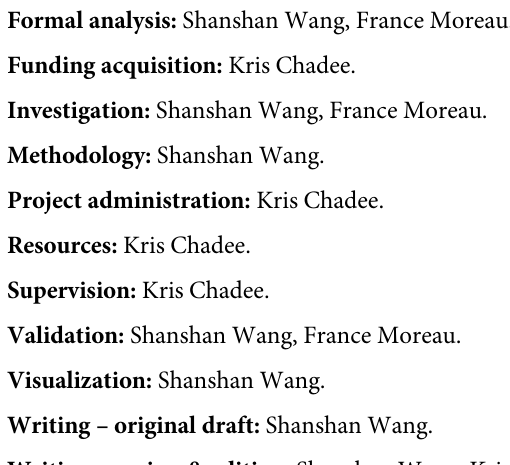
S6 Fig. Protein-protein interaction enrichment analysis on downregulated and upregu- lated pathways following E . histolytica contact with macrophage. Based on the proteomics analysis in Eh -induced hyperactivated macrophages, a protein-protein interaction assay was conducted by STRING protein-protein interaction analysis. ( A ) Shown is the network of enriched terms within the downregulated pathway (Apoptotic signaling pathway and mem- brane trafficking), where connections that share the same cluster typically interact to each other. ( B ) Network demonstrating the interactions between downregulated pathway and upre- gulated pathway (Regulation of proteolysis and secretion by cell) in hyperactivated macro- phages by STRING analysis. ( C ) Volcano plot of proteins from both downregulated and upregulated pathways in Eh -induced hyperactivated macrophages with log2 interpretation.